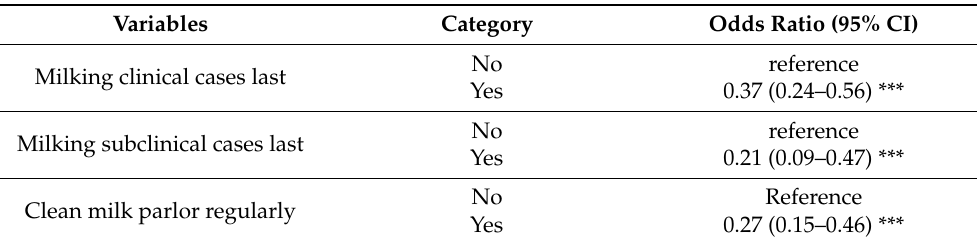
Table 3. Final multivariable logistic regression model of associations between herd level milking management practices and subclinical mastitis (positive California Mastitis Test) at a quarter level in 10 smallholder dairy herds in Piracicaba Mesoregion, S ã o Paulo, Brazil. Variables Category Odds Ratio (95% CI) Milking clinical cases last Milking subclinical cases last